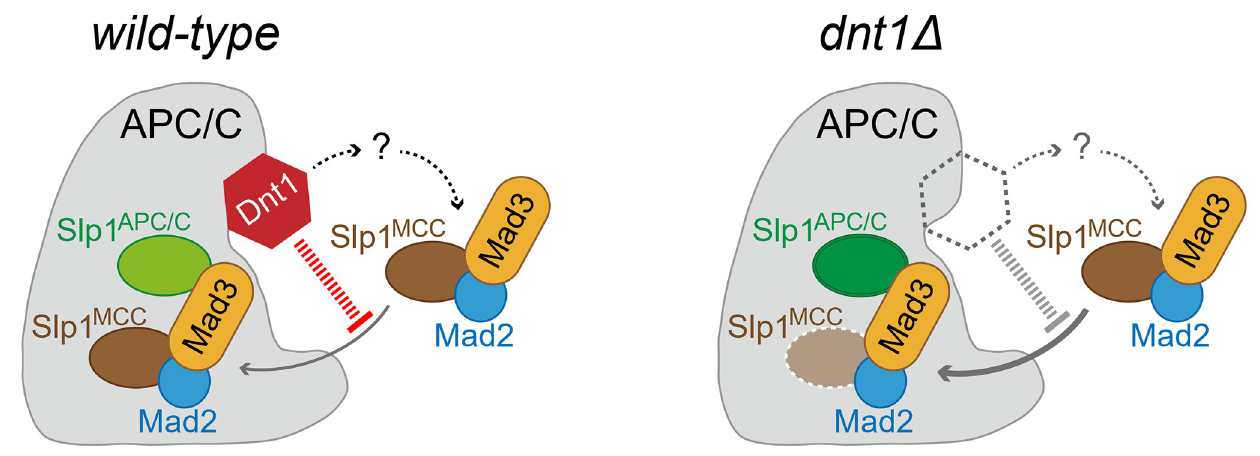
Fig 7. Proposed model for positive regulation of the APC/C activity by Dnt1. Upon SAC activation, APC/C-associated Dnt1 is likely involved in preventing the excessive and prolonged MCC binding to APC/C and thus impeding the degradation of MCC-bound Slp1 Cdc20 by partially activated APC/C. The presence of Dnt1 possibly help to maintain Slp1 Cdc20 protein (likely including both MCC-bound and free Slp1 Cdc20 ) level and APC/C Cdc20 activity. Lighter brown color of Slp1 MCC depicts lower levels of Slp1 Cdc20 present in MCC in dnt1 Δ cells, which is likely caused by Apc15-faciliated autoubiquitylation and degradation. Darker green color of Slp1 APC/C depicts higher levels of activation-incapable Slp1 Cdc20 “trapped” in APC/C in dnt1 Δ cells. In parallel, Dnt1 may also indirectly regulate the inhibitory action of MCC on APC/C (dotted arrows) through a yet unrecognized factor/mechanism (question